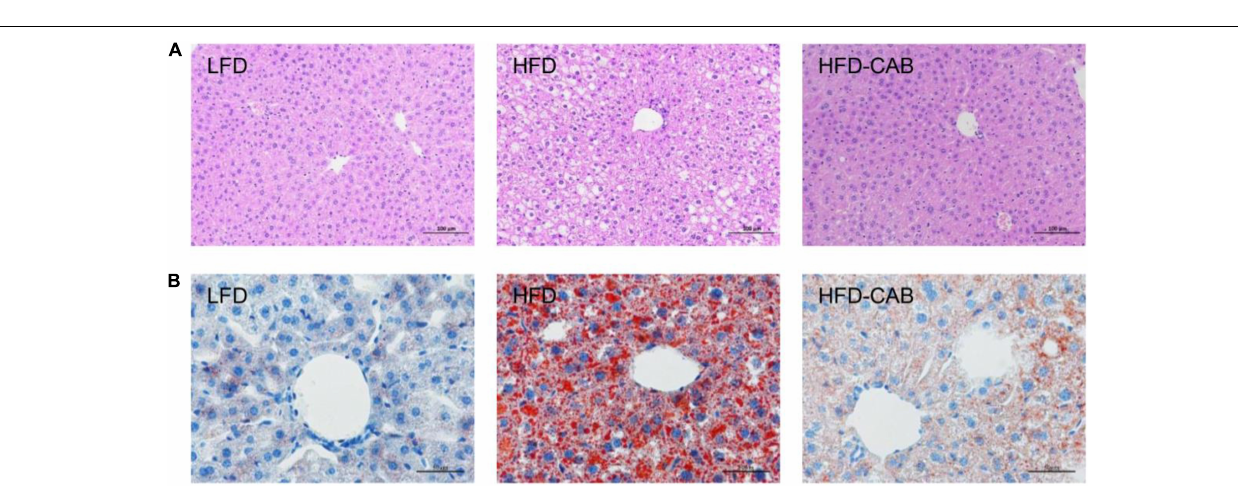
FIGURE 3 | Cooked adzuki bean limits HFD-induced hepatic steatosis. (A) H&E staining of liver tissue sections, and (B) Liver Oil Red O staining. n = 7 per group. LFD, low-fat diet; HFD, high-fat diet; HFD-CAB, high-fat diet supplemented with cooked adzuki